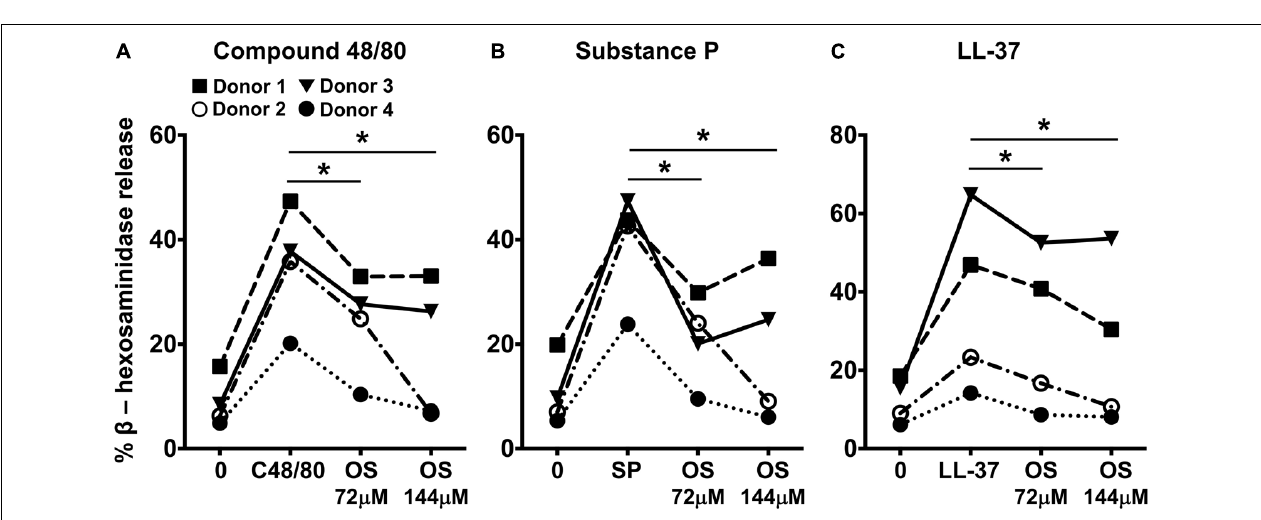
FIGURE 4 | Osthole attenuates MRGPRX2-mediated degranulation in human skin mast cells. (A–C) Human skin-derived mast cells were pre-treated with osthole (OS, 72 and 144 µ M) and exposed to (A) compound 48/80 (C48/80, 100 ng/ml), (B) substance P (SP, 300 nM) or (C) LL-37 (3 µ M). Graphs show degranulation of mast cells as estimated by β -hexosaminidase release in supernatants. Data shown are from 4 different human donors with each symbol representing a single donor. Statistical significance was determined by paired Student’s t -test * p < 0.05 and ** p <